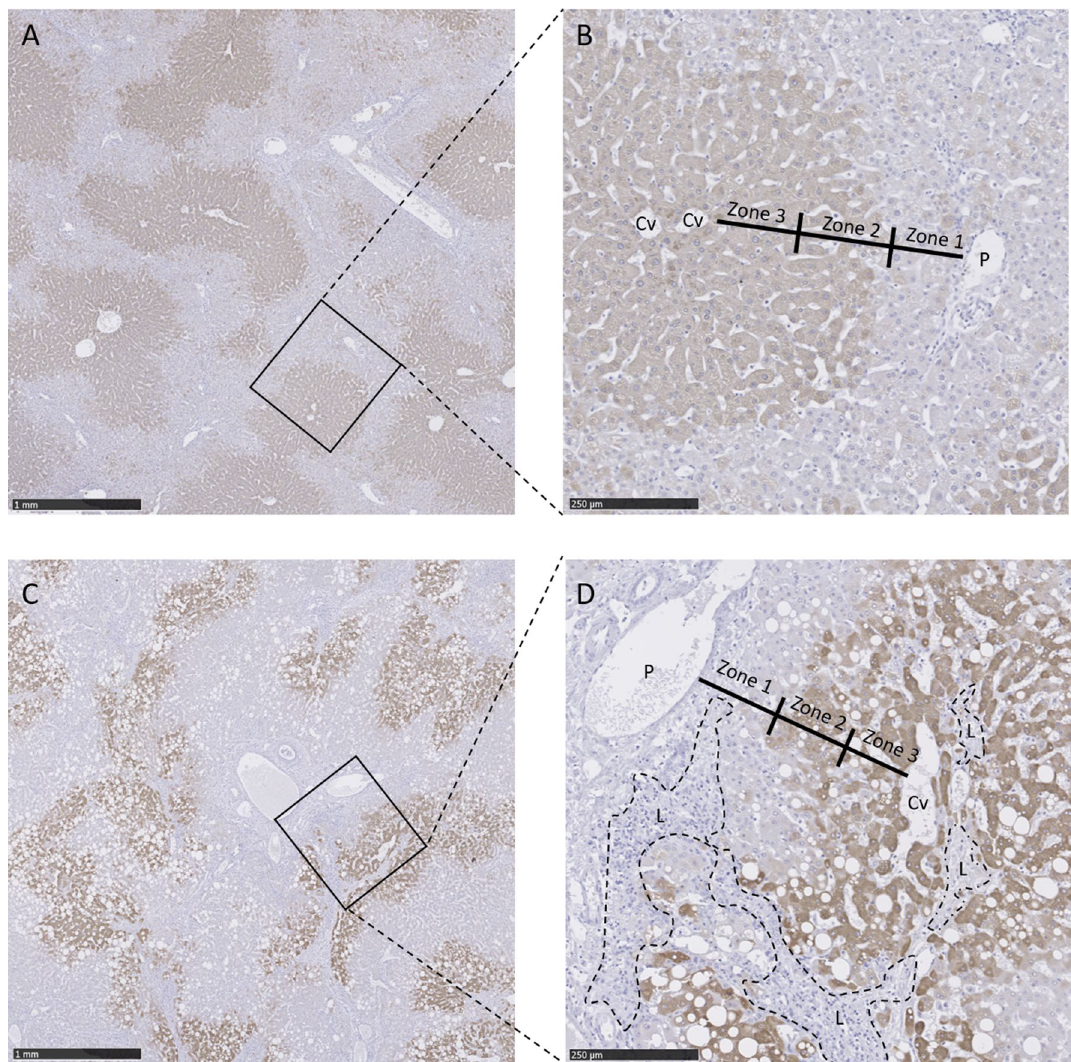
Figure 2. Histologic evaluation of biopsies from machine perfused livers stained with CYP1A2 immunohistochemistry. ( A , B ) Present liver H8 and panels C and D present liver H4. ( A ) and ( C ) consist of a low magnification picture (× 100). ( B ) and ( D ) display a high magnification (× 400). The portal vein (in the portal tract area) is represented by P, Cv represents the central vein, and L represents lymphocytic infiltrate. Zone 1, 2, and 3 represent the hepatic metabolic zones (as defined by the acinus of Rappaport). Zone 1 is the peri-portal zone, zone 2 is the intermediate zone, and zone 3 is the peri-central zone. H8 has normal liver microscopy; in this liver, it is visible that CYP1A2 is the cytoplasmatic hepatocellular stain highly present in zone 2 and 3, and it is less prominent in zone 1. H4 is microscopically a relatively injured graft. In this graft, lymphocytic infiltrates are present, causing hepatocyte loss and, therefore, loss of CYP1A2 positive